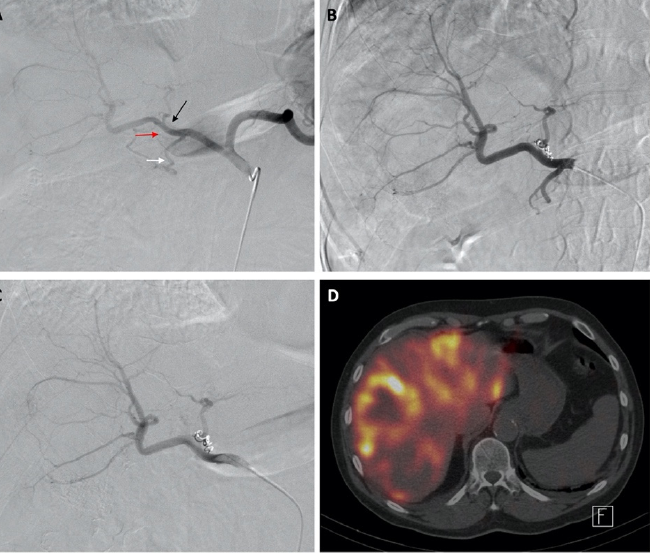
Figure 3. Images of a patient given diagnostic Tc-99m MAA injections. Digital subtraction angi- ography from the celiac axis showed hepatofugal flow within the GDA (white arrow), RGA coming from the LHA (black arrow), and retroportal artery (red arrow) ( A ). A repeat celiac arteriogram through the balloon catheter in the CHA after RGA embolization redemonstrated the hepatofugal flow in the GDA and retroportal artery ( B ) with successful flow reversal after inflating the balloon ( C ). Nuclear scintigraphy using SPECT/CT after Tc-99m MAA administration showed satisfactory distribution of it within the liver without significant extrahepatic uptake ( D